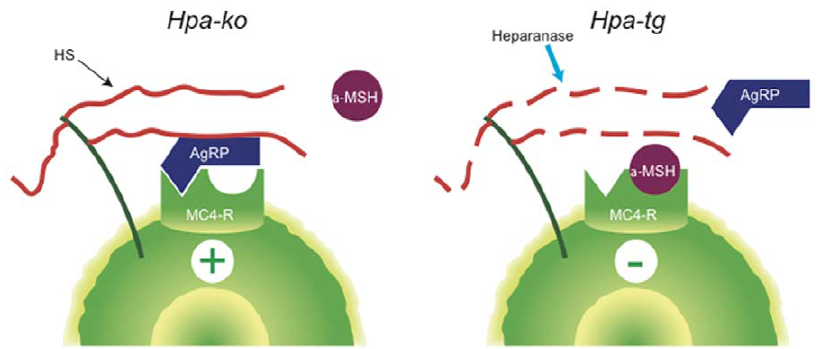
Figure 5. Proposed effects of heparanase on MC4R signaling. HS chains of a cell-surface HSPG serve as co-receptors for AgRP, and at the same time preclude access of a -MSH to the MC4R. (Left panel) In the absence of heparanase ( Hpa- ko) the HS chains remain intact, resulting in continuous AgRP-induced activation of MC4R, thus promoting food consumption, fat accumulation, and a positive energy balance. Under these conditions a -MSH signaling is severely restricted. (Right panel) HS chains are degraded by overexpressed heparanase ( Hpa- tg), thus rendering the MC4R accessible to a -MSH, whereas AgRP devoid of its HS co-receptor is unable to engage the MC4R and thus remains inactive. This setting explains the acute effects of ICV-injected heparanase that lead to transient yet drastic reduction in feeding. However, it is also compatible with the long-term effects of transgenic heparanase expression that shift energy balance toward increased loss of body fat and compensatory up-regulation of appetite.